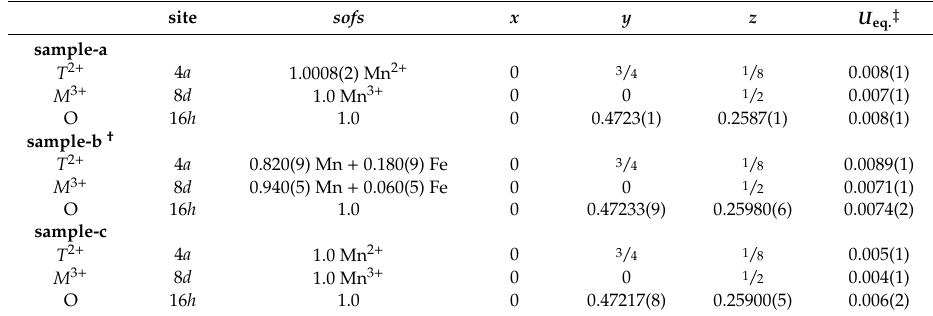
Table 5. Atom coordinates and equivalent isotropic displacement parameters (Å 2 ) for three hausmannite samples.